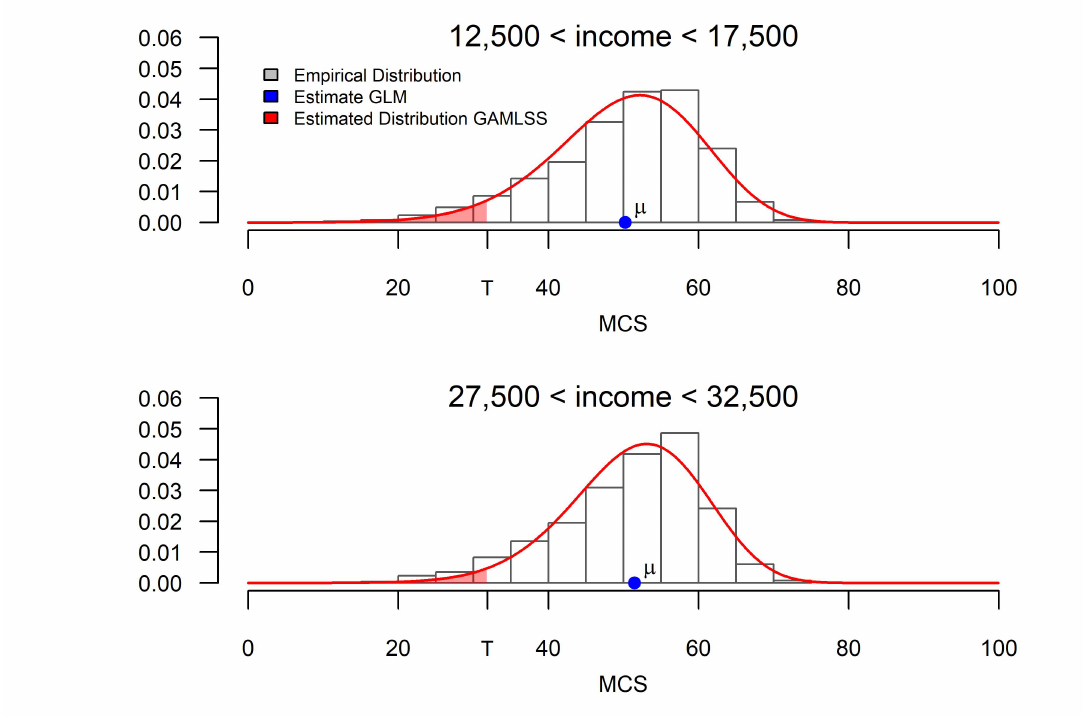
Figure 1. Comparison of estimates between GLM and